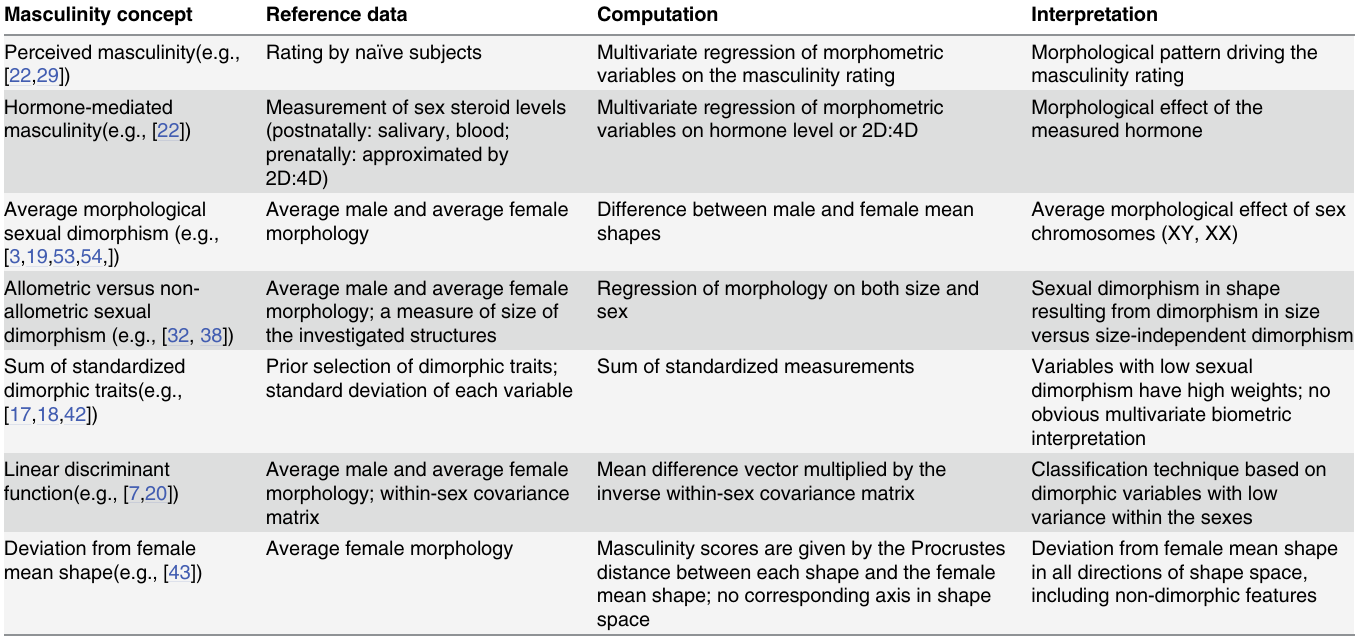
Table 1. A selection of different masculinity concepts and their statistical